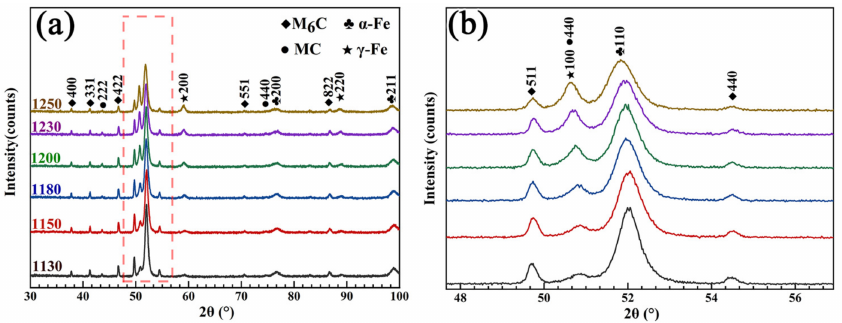
Figure 7. XRD patterns. ( a ) The different quenching temperatures; ( b ) partially enlarged